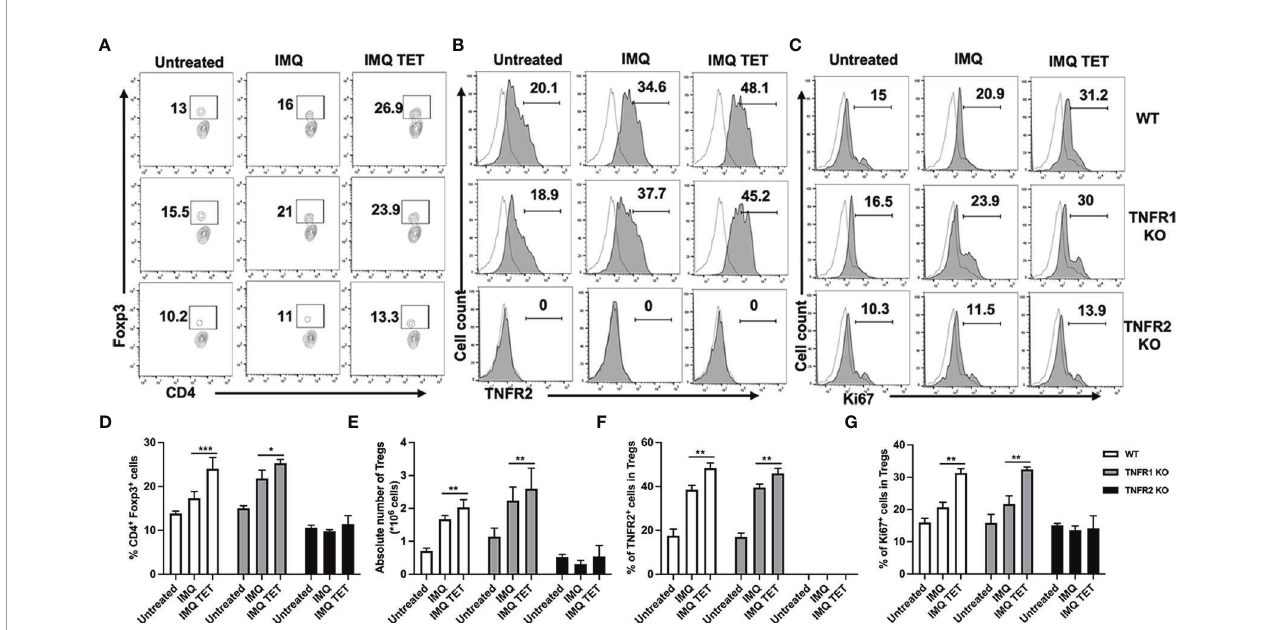
FIGURE 6 | The anti-in fl ammatory effect of TET NE is based on the expansion of naturally occurring CD4 + Foxp3 + regulatory T cells by TNF-TNFR2 signaling. WT, or TNFR1 -/- or TNFR2 -/- mice (N = 9) were treated with IMQ for 6 days. TET NE treatment starts from the second day after IMQ treatment for 5 days. 24 hours later, the mice were sacri fi ced. The proportion of Tregs in CD4 cells (gating on TCR b + CD4 + cells, A, D ), expression of Ki-67 by Tregs (gated on Foxp3 + Tregs, C, G ), and expression of TNFR2 by Tregs (gated on Foxp3 + Tregs. B, F ) in the spleen were analyzed with FACS. The number of Tregs in the spleen is shown in (E) . (A – C) Representative FACS data are shown. The number in the FACS data indicates the proportion of gated cells. Dot histogram: isotype control. (D – G) show summarized data. Data were shown as means ± SEM. * P < 0.05, ** P < 0.01, *** P < 0.001, compared with IMQ